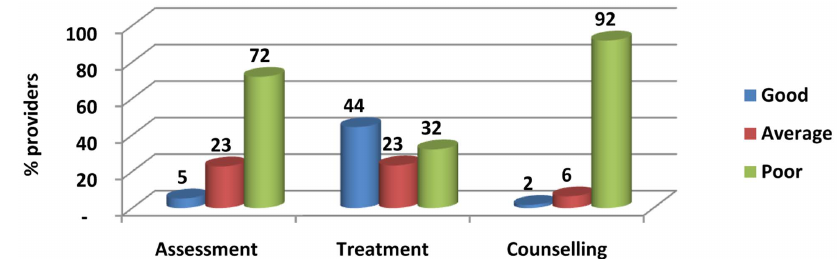
Figure 3. Ranking of ANC Services for Assessment Treatment and Counselling. doi:10.1371/journal.pone.0113390.g003 PLOS ONE |